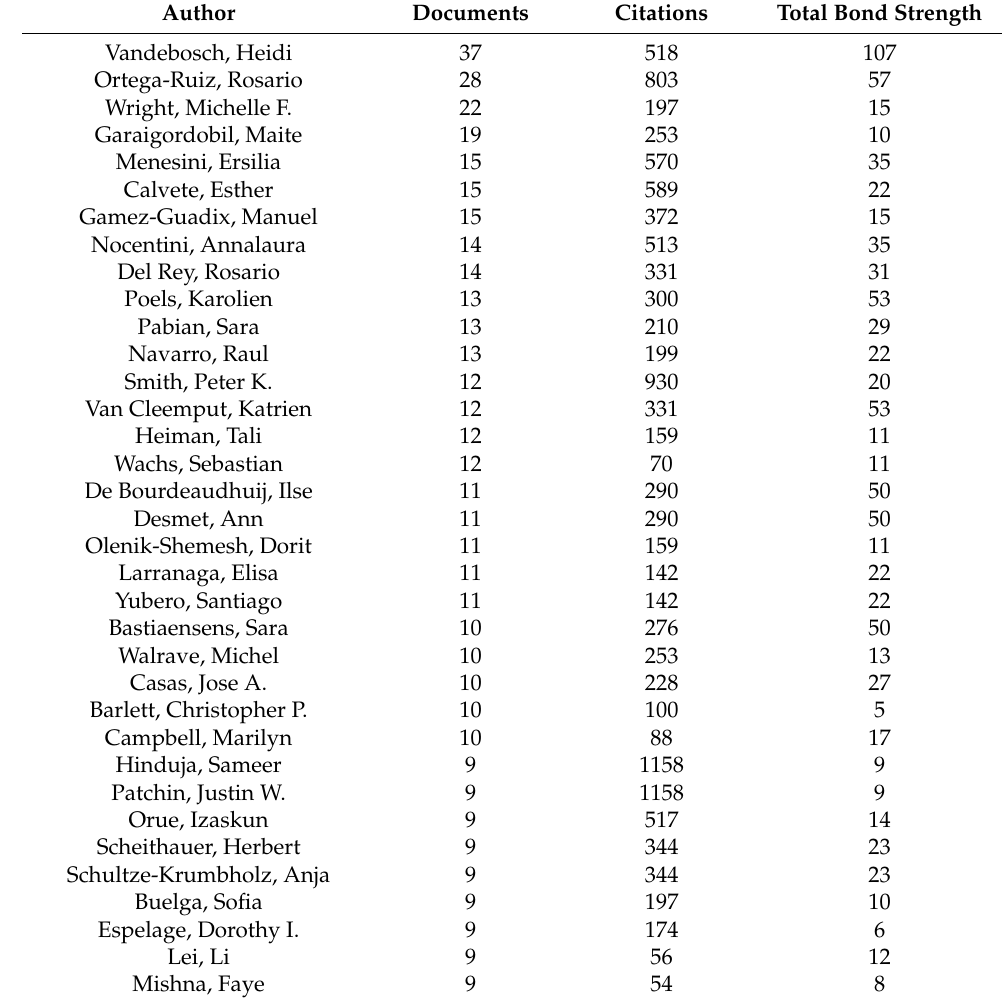
Table 2. Number of documents and citations and strength of co-authorship